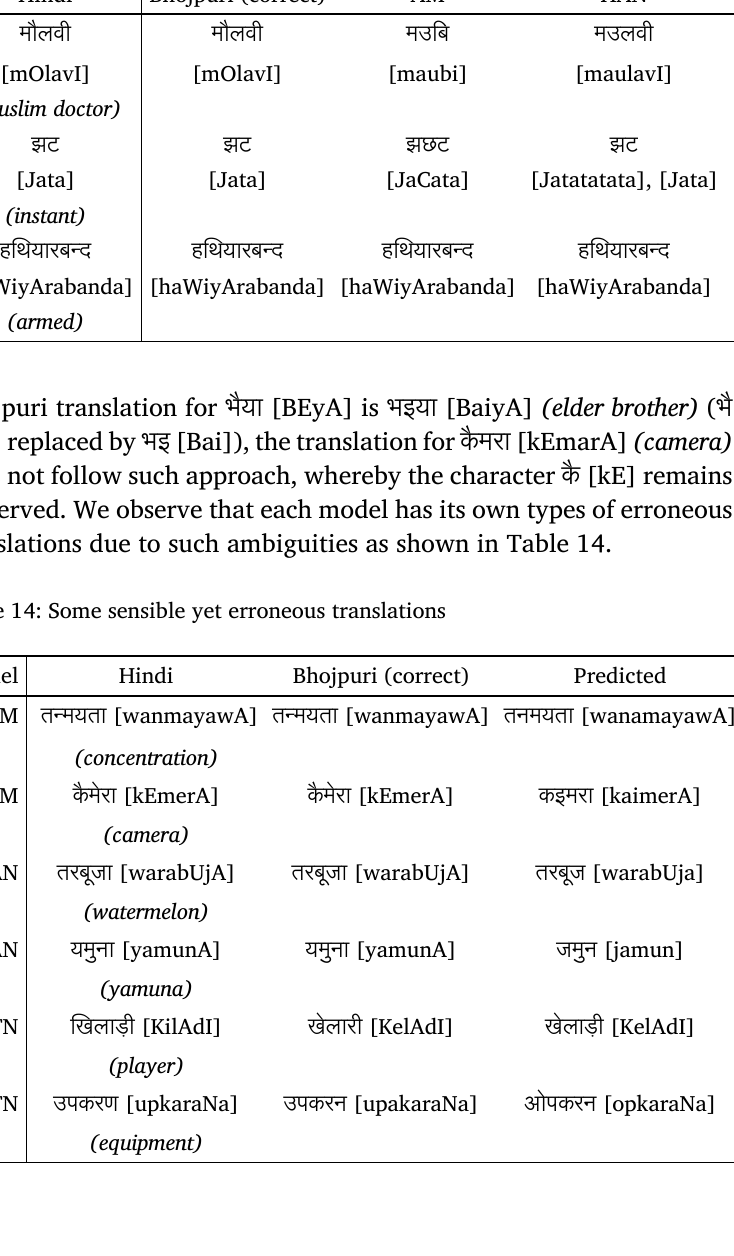
Table 13: Performance on identical translations Hindi